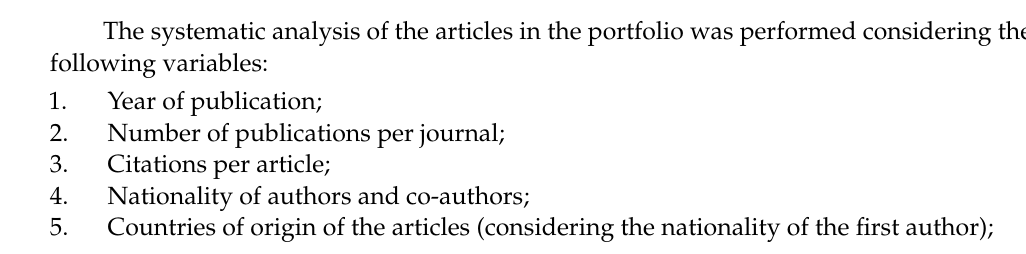
Figure 1. Workflow of the Methodi Ordinatio. Source: adapted from Pagani, Resende, and Kovaleski